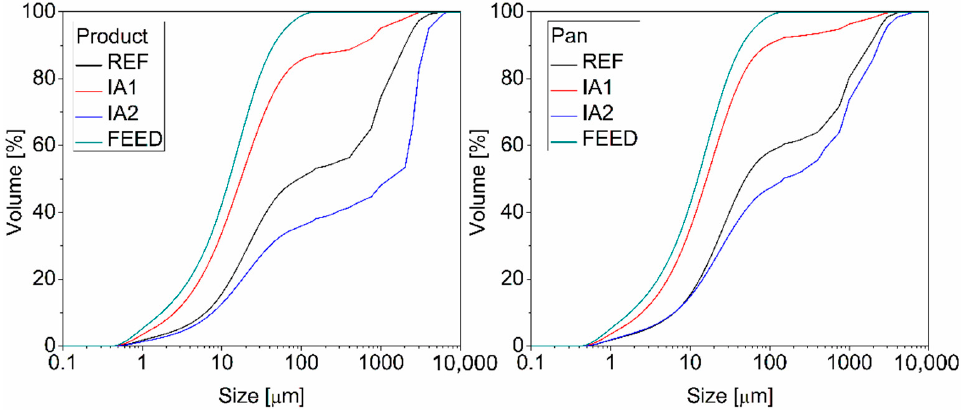
Figure 9. Influence of IA on PSD of product and pan samples of the granulation.